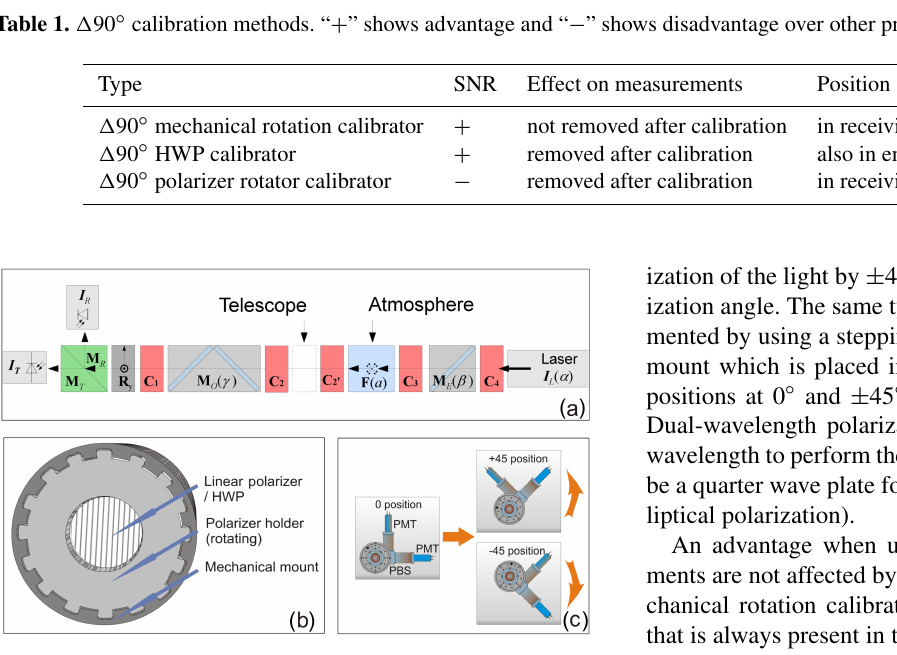
Figure 3. Calibration blocks: (a) schematics of a polarization sen- sitive lidar system with Mueller matrix block elements, different calibrator positions (red blocks – C); (b) multi-angle mechanical rotator mount for the (cid:49) 90 ◦ polarizer calibrator or the (cid:49) 90 ◦ opti- cal calibrator. 22.5 ◦ rotation step. HWP is a half-wave plate; (c) mechanical rotator for the (cid:49) 90 ◦ mechanical calibrator. PMT is a photomultiplier, PBS is a polarizing beam